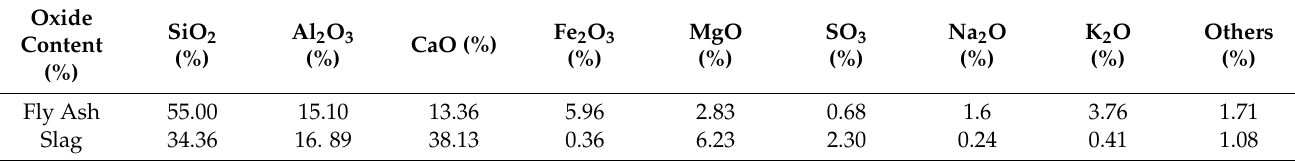
Table 2. Chemical composition of the base phase material.